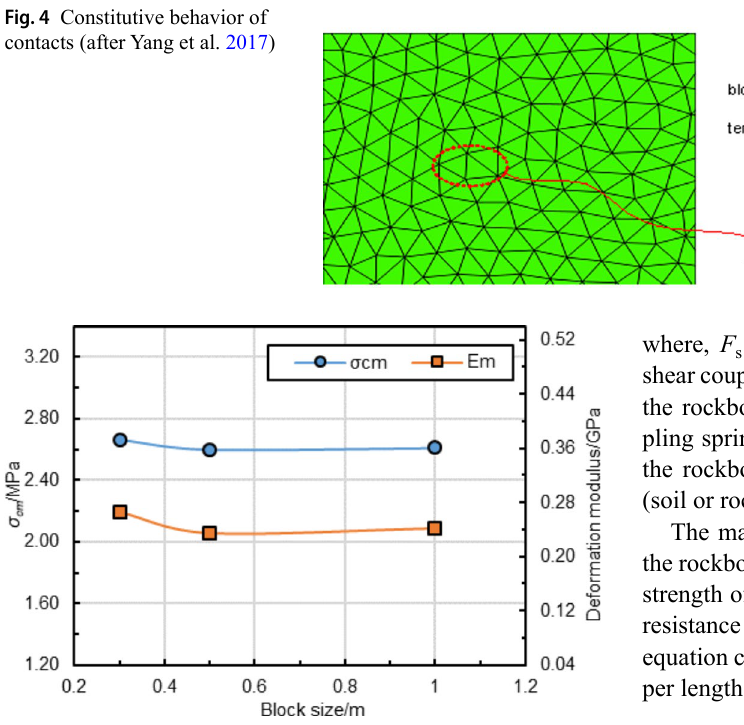
Fig. 5 Influence of different block sizes on simulated material proper - ties. (The block edge length of 0.3 m, 0.5 m, and 1 m were used in the sensitivity study)